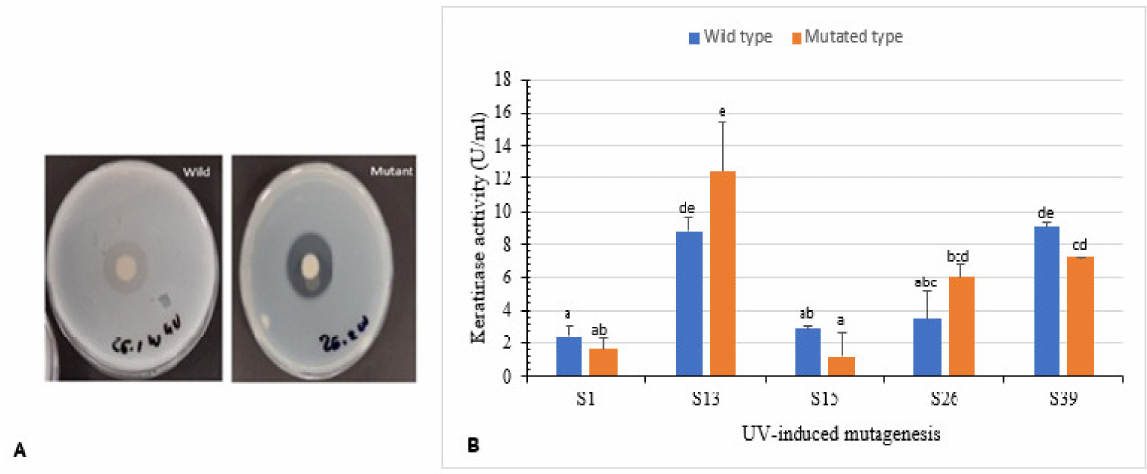
Figure 4. Effect of UV-random mutagenesis on keratinase activity. ( A ) Wild and UV-mutated isolate S26 showing clear zone of hydrolysis on skim milk agar. ( B ) Keratinolytic activity of wild isolates and their corresponding mutants. Bars are the standard error of the mean. Mean with the different letters are significantly different according to Duncan’s at p < 0.05.